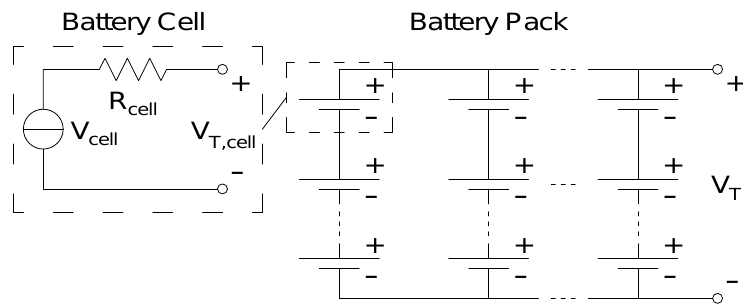
Figure 3. Battery pack equivalent